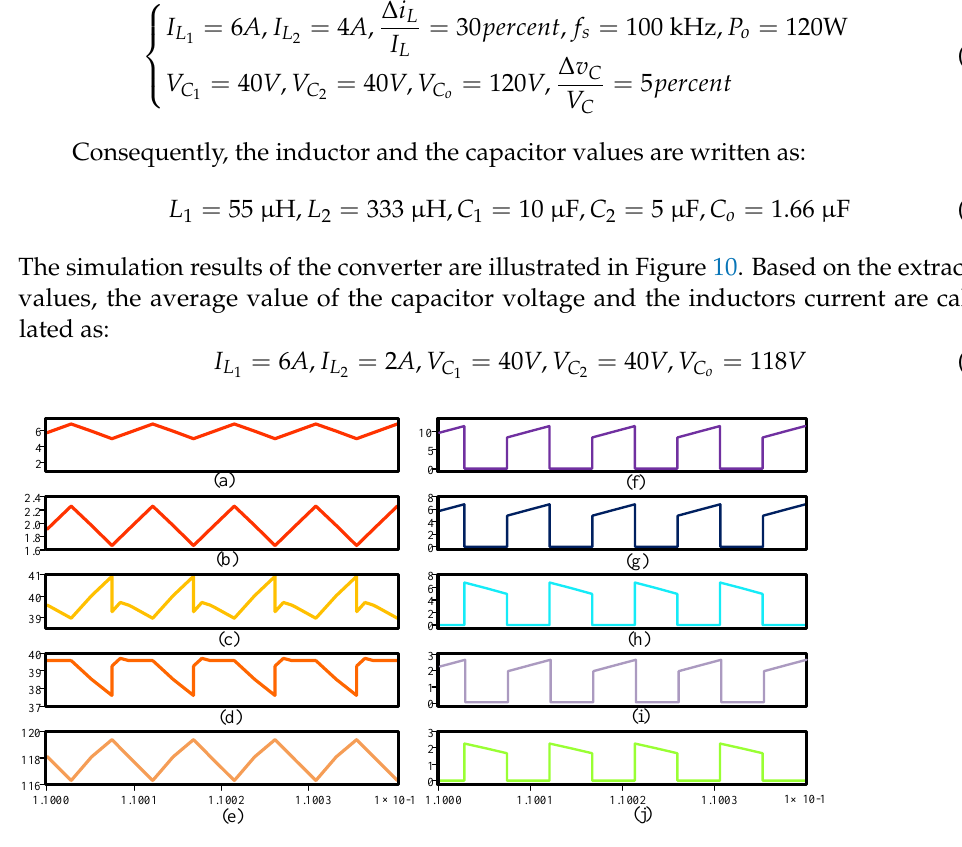
Figure 10. Simulation results: the ( a ) current of L 1 , ( b ) current of L 2 , ( c ) voltage of C 1 , ( d ) voltage of C 2 , ( e ) voltage of C o , ( f ) current of S 1 , ( g ) current of D 1 , ( h ) current of D 2 , ( i ) current of D 3 , and ( j ) current of D 4